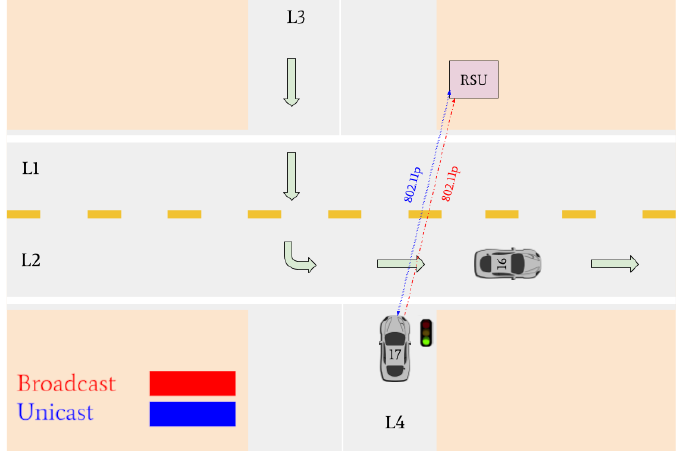
Figure 21. Vehicle 16 turns right. Vehicle 17 receives a green light from the RSU to turn right.